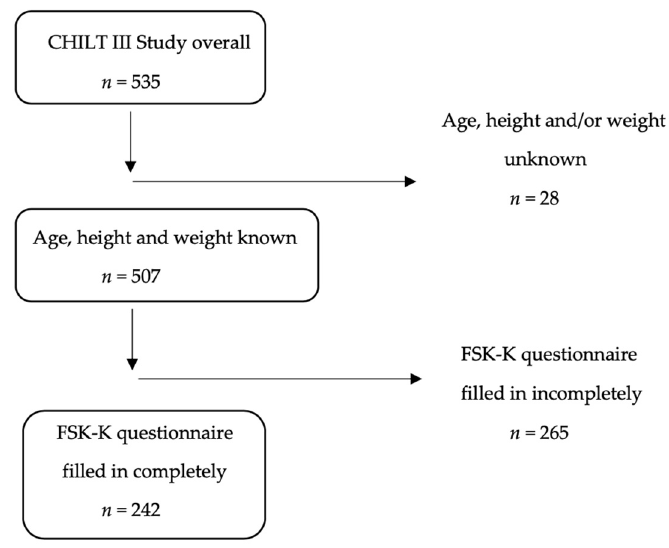
Figure 1. Inclusion criteria for the study population. The years between 2005 and 2020 were divided into six time periods of two to three years each. Each time span or period contained a similar number of study participants, with a mean of n = 40, a maximum of n = 45 (2015–2017) and a minimum of n = 34